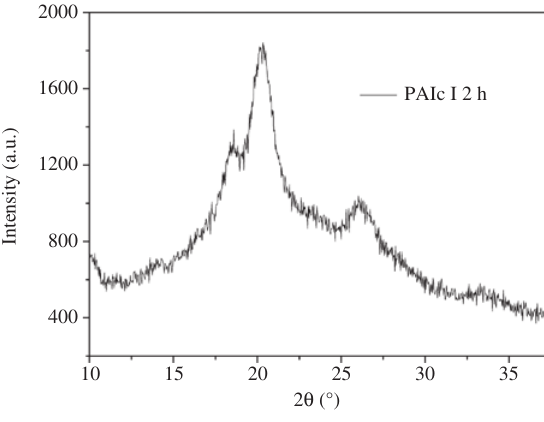
Figure 9: Wide-angle X-ray diffractograms of PAIc